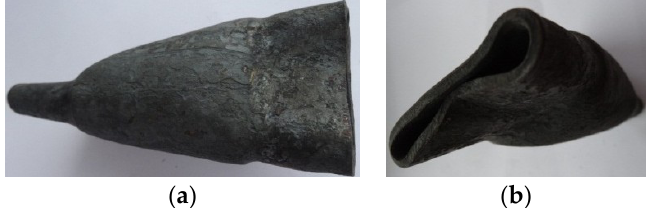
Figure 11. Shape of the forging obtained from thin-walled semi-finished products with small relative wall thickness t o /D = 0.095 and relative speed v/n = 2 mm/rotation Figure 12. Deformation of the compressed forging, resulting from an overly thin wall of the billet ( v / n = 4 mm / rotation, δ = 1.5): ( a ) front forging view, ( b ) side forging